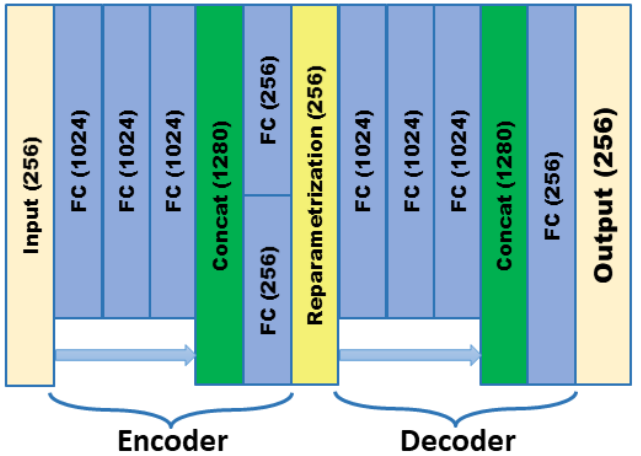
Figure 7. Structure of stage 2 in the Adversarial-VAE model.